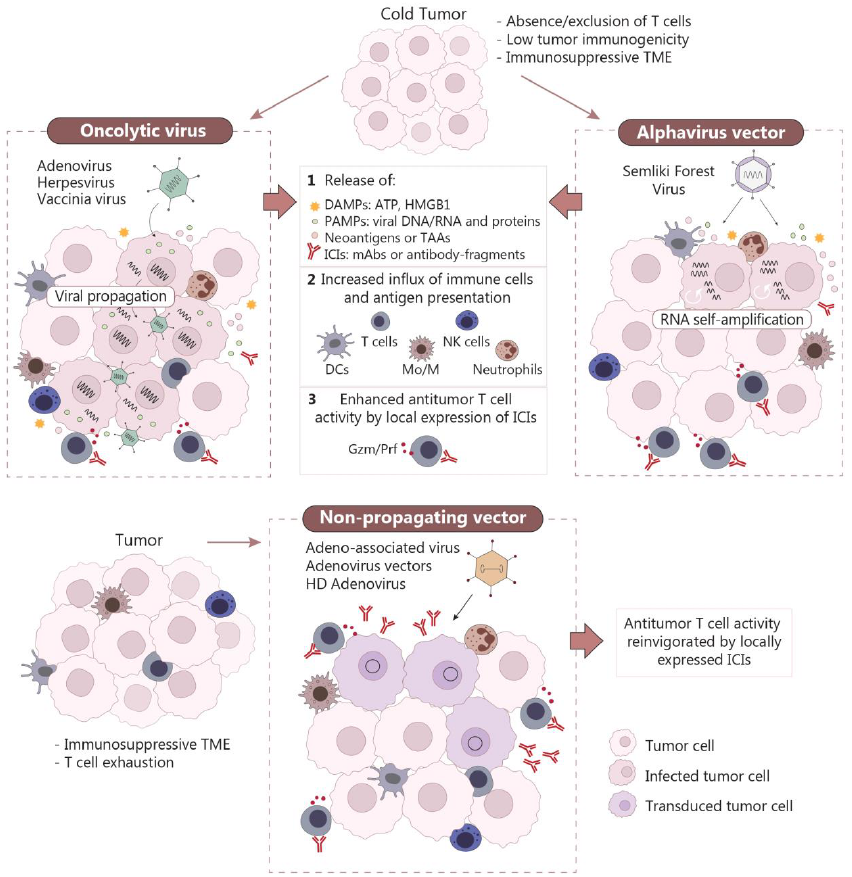
Figure 2. Mechanisms of action of gene therapy vectors encoding antibodies against immune check- points. Oncolytic viruses and alphavirus vectors based on self-amplifying RNA are able to induce inflammation in tumors through the release of PAMPs (pathogen-associated molecular patterns) and DAMPs (damage-associated molecular patterns) due to the immunogenic death of tumor cells. These processes favor the infiltration of immune cells in the tumor, which can be further activated by locally expressed ICIs (upper panel). Non-propagating vectors are usually less immunogenic; however, local delivery of ICIs by these vectors can promote the activation of tumor-infiltrating im- mune cells (lower panel). TME, tumor microenvironment; HMGB1, high mobility group box 1; TAAs, tumor-associated antigens; ICIs, immune checkpoint inhibitors; DCs, dendritic cells; Mo/M, monocytes/macrophages; NK, natural killer; Gzm/Prf, granzyme/perforin; HD, helper-dependent.